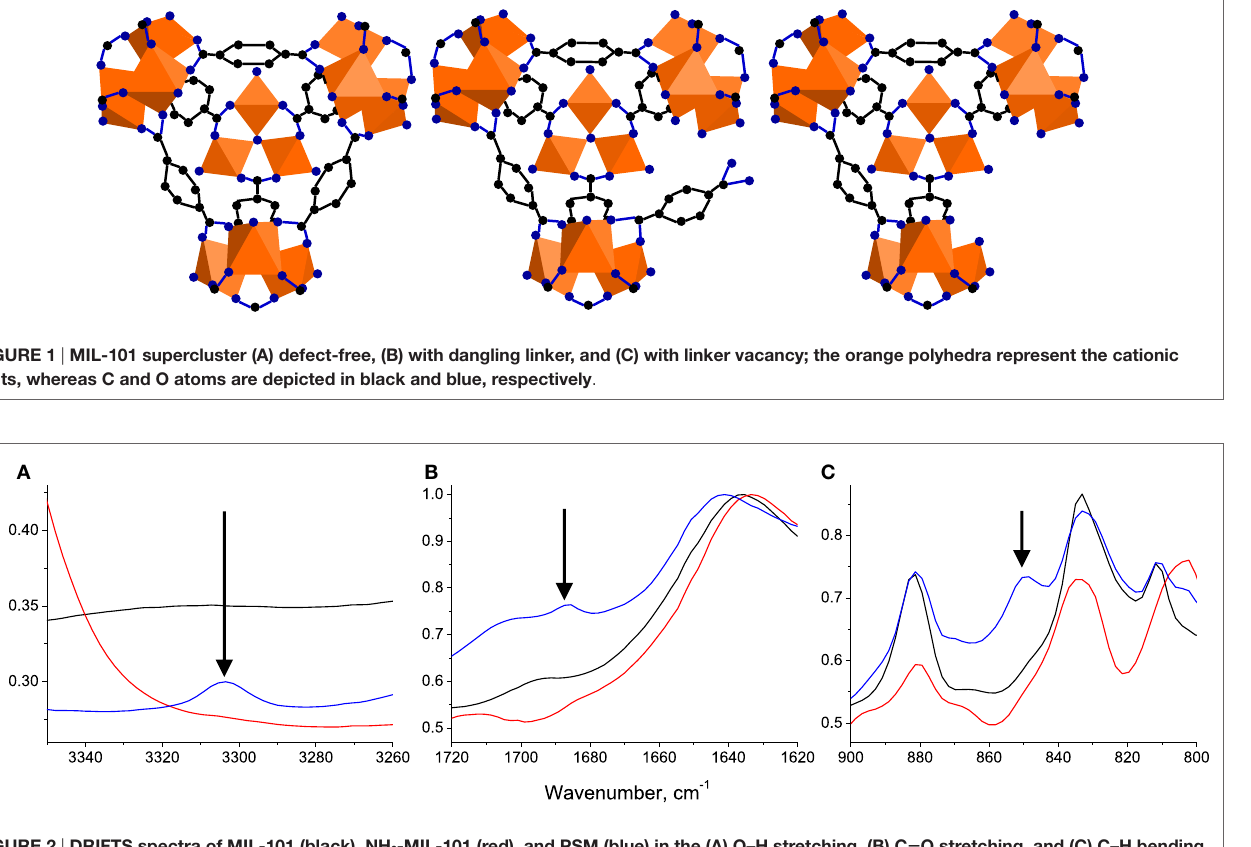
FigUre 2 | DriFTs spectra of Mil-101 (black), nh 2 -Mil-101 (red), and PsM (blue) in the (a) O–h stretching, (B) c = O stretching, and (c) c–h bending regions